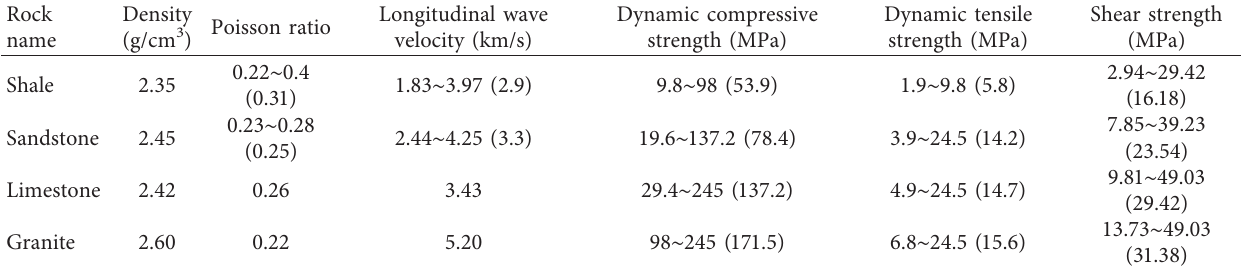
Table 1: Physical-mechanical parameters of the four types of rocks [28].